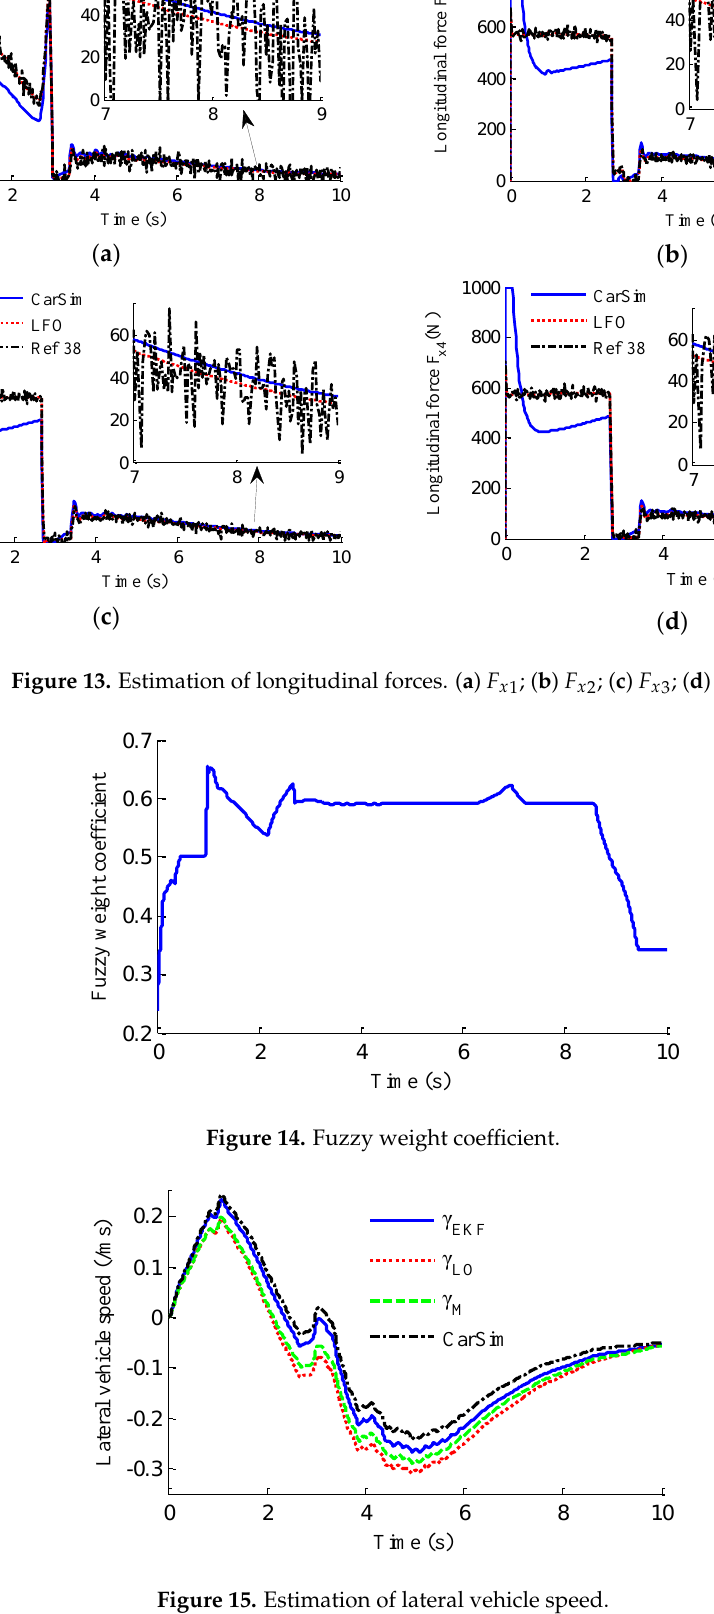
Figure 15. Estimation of lateral vehicle speed.